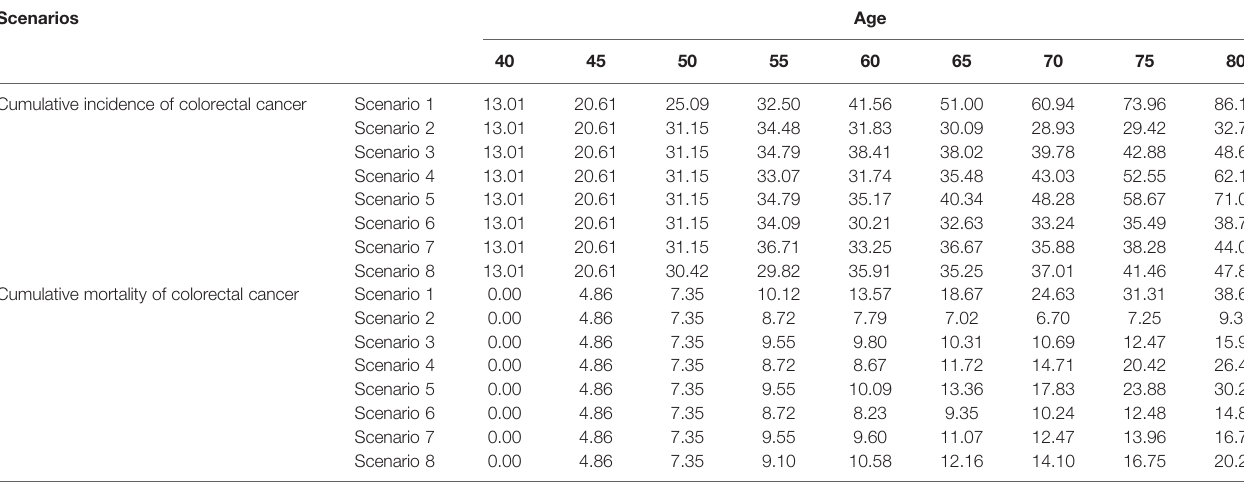
TABLE 2 | Cumulative colorectal cancer incidence and mortality (/100,000) at different ages in 8 screening scenarios. Scenarios